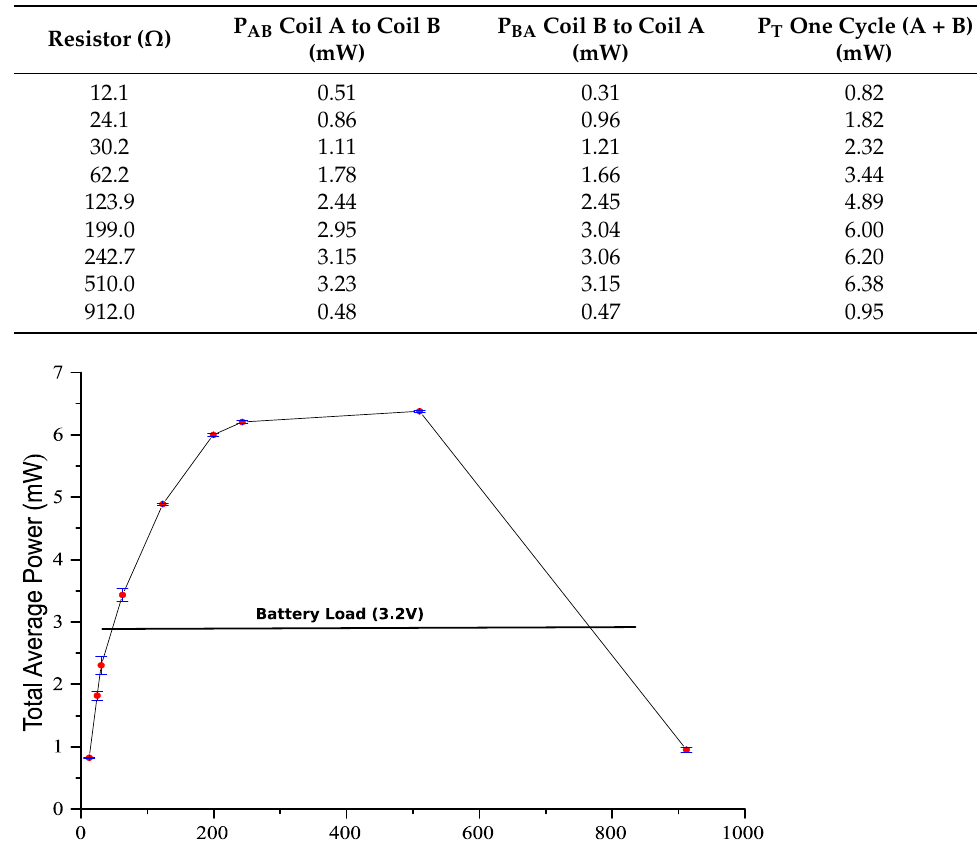
Table 4. Average power vs. load in freefall test.